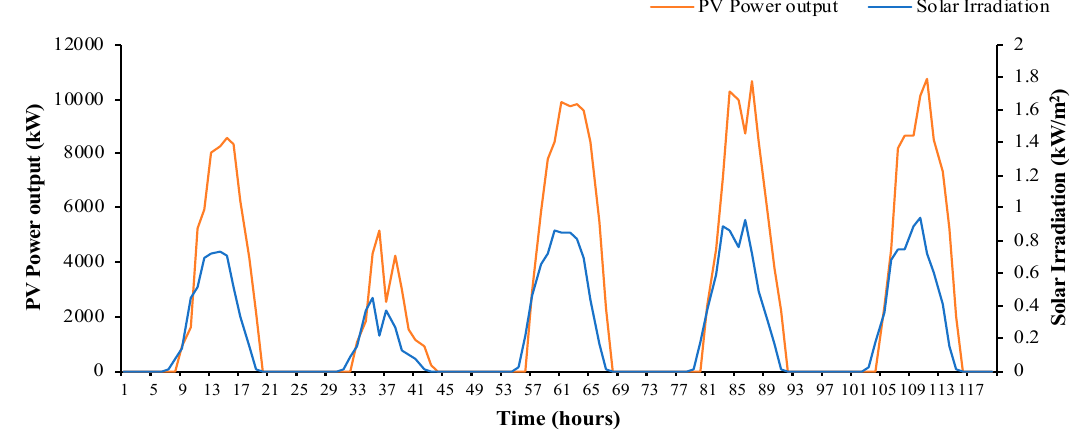
Figure 10. PV power output and solar irradiance.